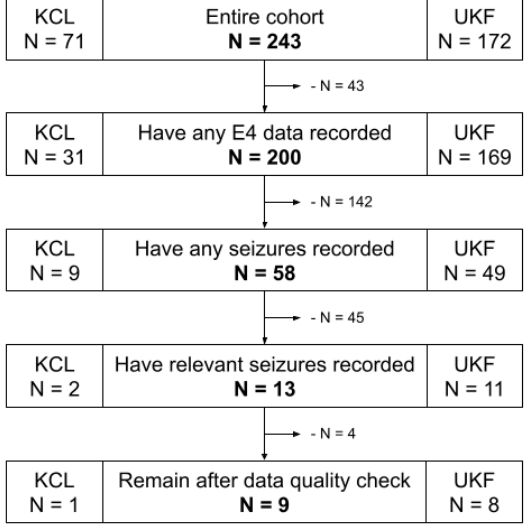
Figure 2. Data set flowchart of the participant selection process. KCL: King’s College London;